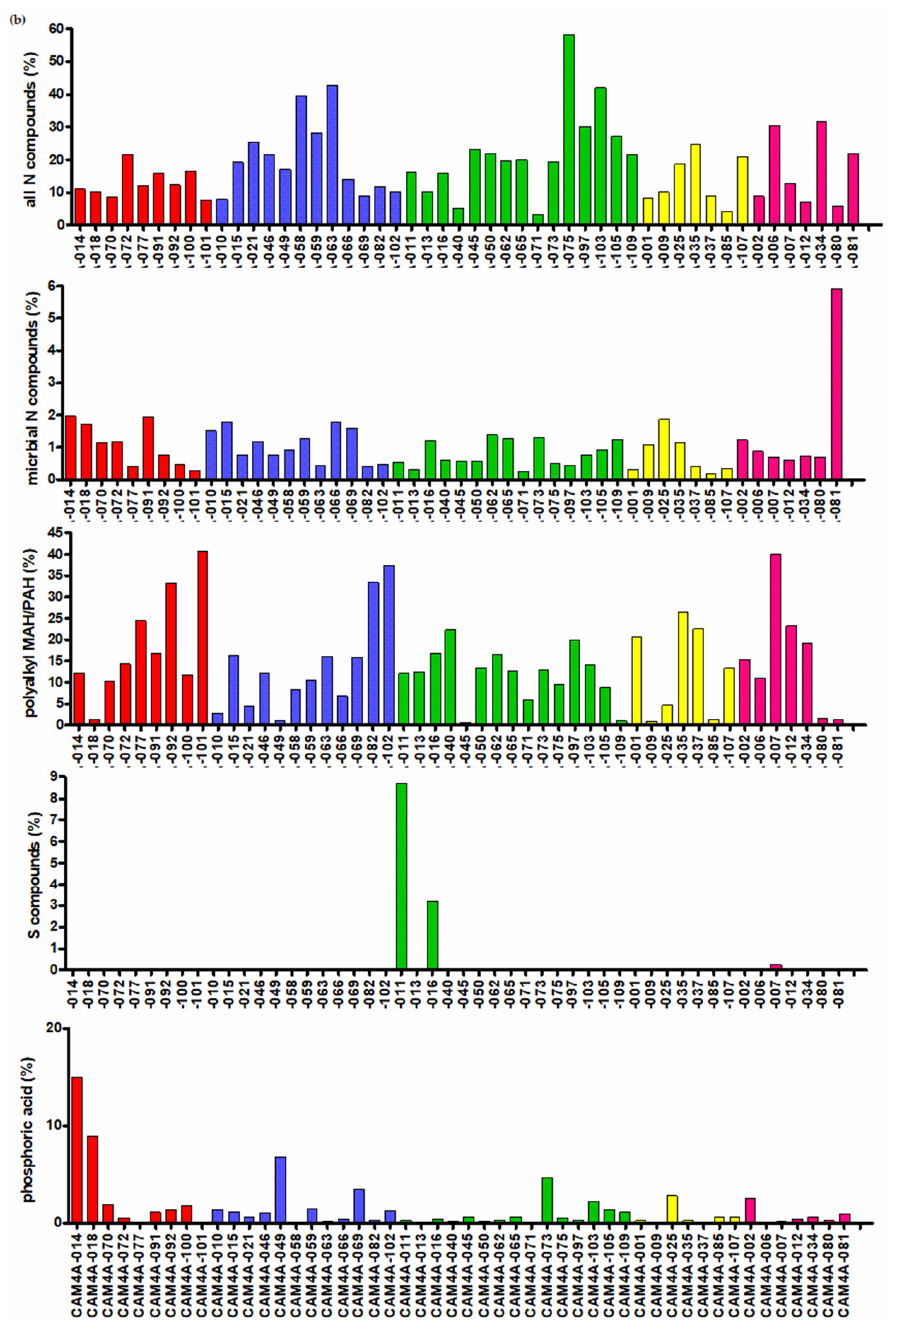
Figure 4. ( a ) Relative proportions of major groups of THM products: all FAMEs, bacterial-derived FAMEs; plant-derived FAMEs (cutin); lignin products and PyOM products. ( b ) Sum of N-compounds; microbial N-compounds (succinimide, uracil), poly-alkyl-aromatic MAHs and PAHs; S-compounds; methylated phosphoric acid. olors indicate cultural periods (red: Neolithic, blue: Early Bronze Age; green: Middle Bronze Age, yellow: Late Bronze Age I, magenta: Late Bronze Age II).